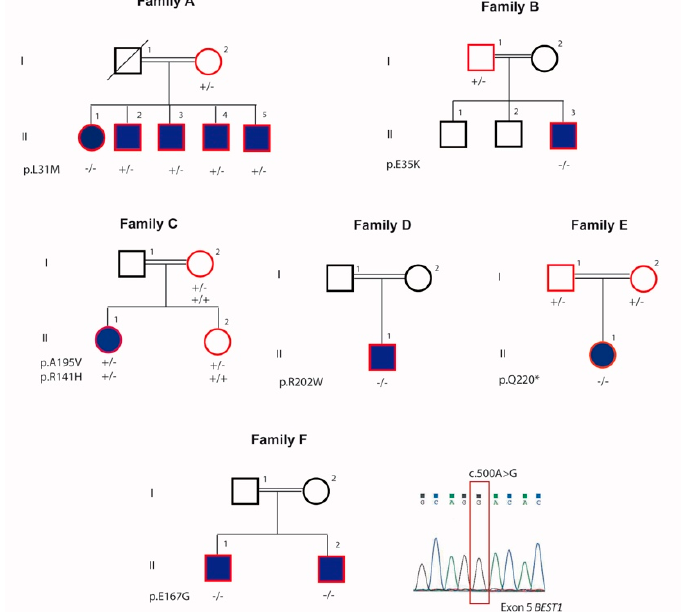
Figure 1. Pedigrees of the 6 families included in this study and segregation analysis of the biallelic mutations of BEST1 . Squares represent men, and circles represent women. Solid symbols indicate patients a ff ected with bestrophinopathy. Unfilled symbols represent una ff ected family members. Symbols with red lining represent studied